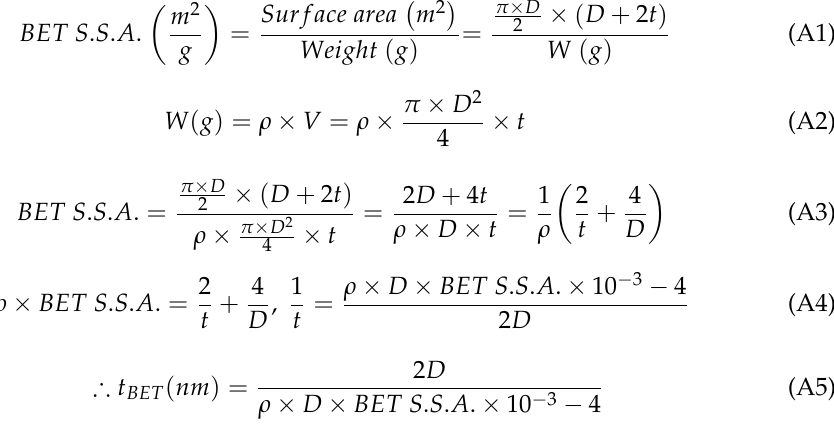
Figure A2. Schematic diagram of morphology assumptions for calculating the thickness of